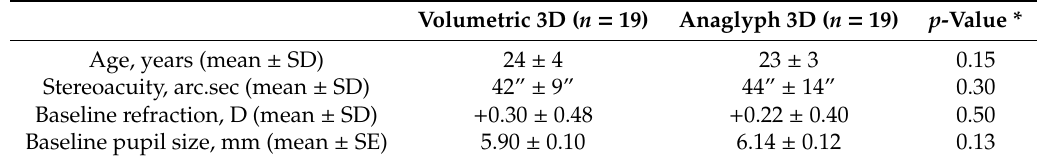
Table 1. Relevant characteristics of the participants in Volumetric 3D and Anaglyph 3D